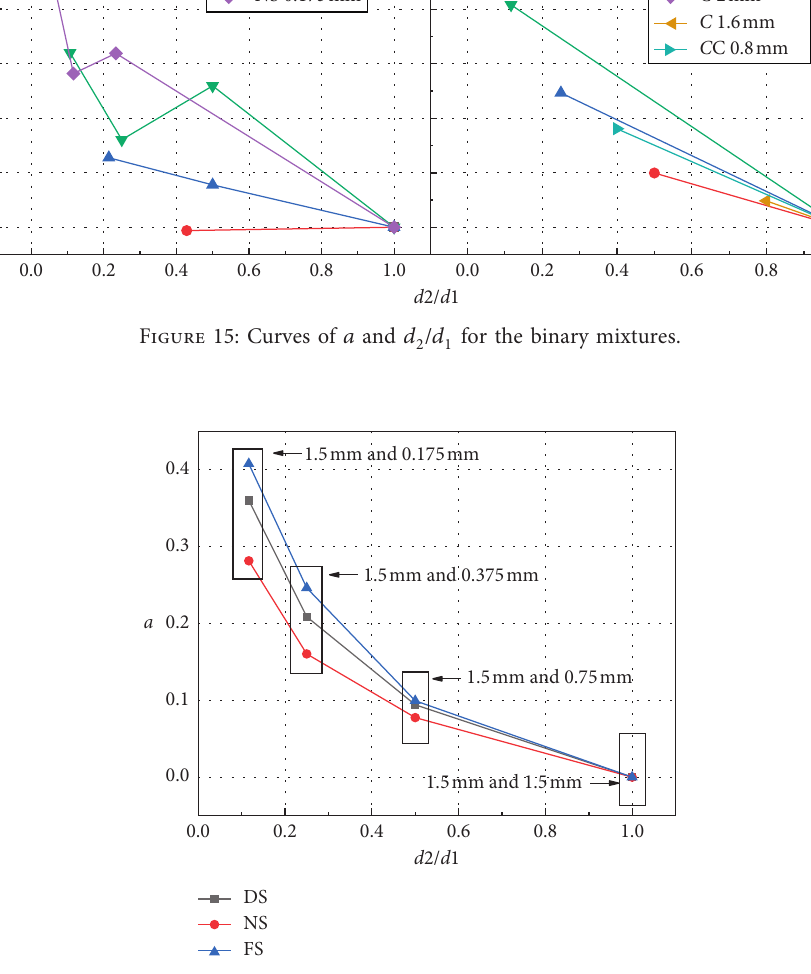
/ d under the same particle size 2 1